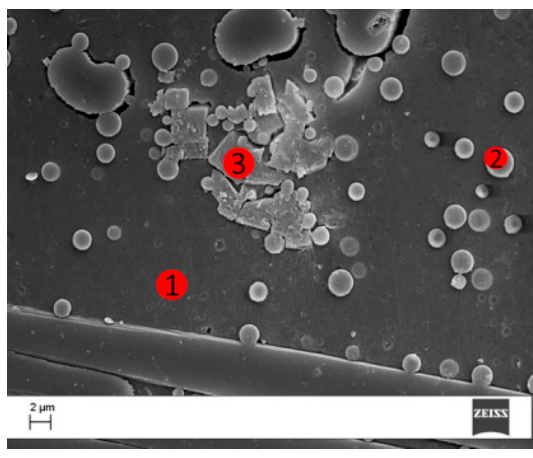
Figure 10. High resolution SEM images of the laminate obtained with the coPES/1% POSS veil. Polymers 2017 , 9 , 281 10 of 15